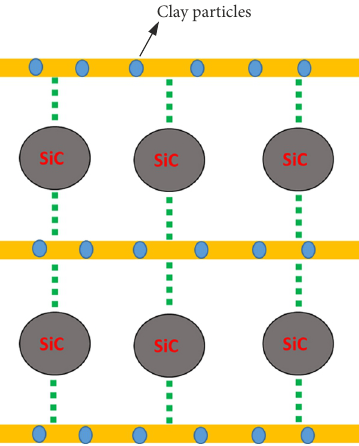
Figure 4. Schematic representation of interaction between clay and silicon carbide nanoparticles